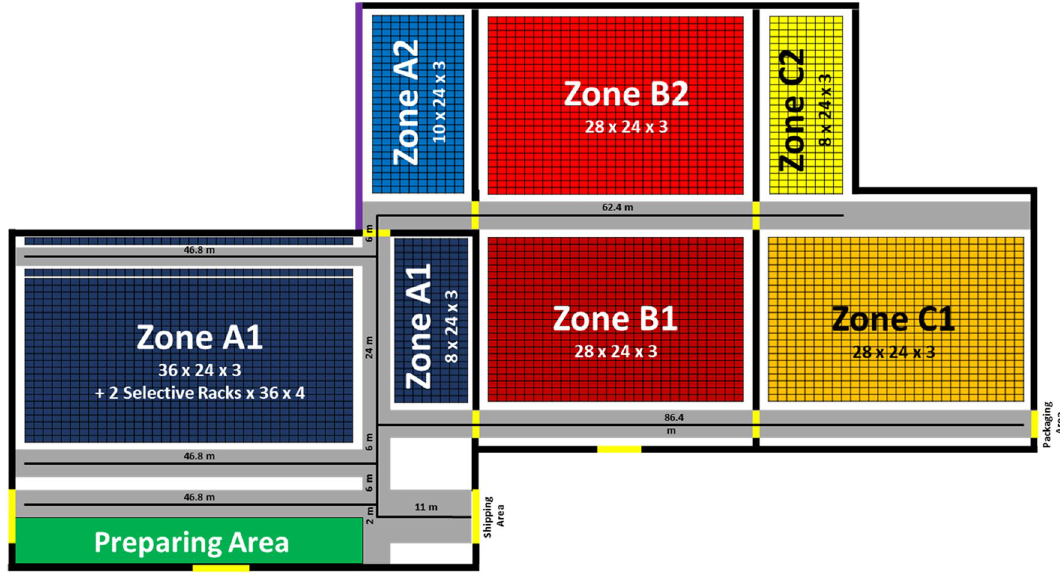
Fig. 4 The retail layout with aisles distances